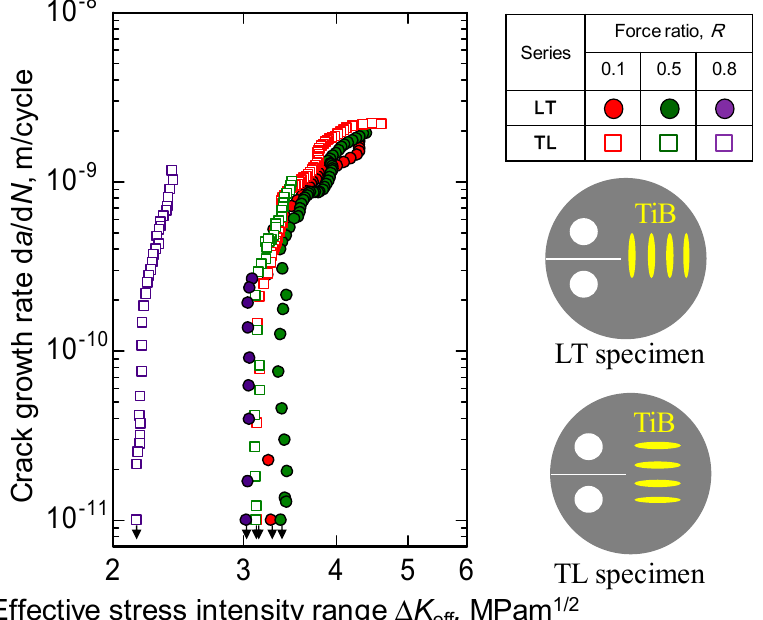
Figure 5. Relationship between crack growth rate and effective stress intensity range for TiB/Ti-3Al-2.5V composites having different TiB orientations.